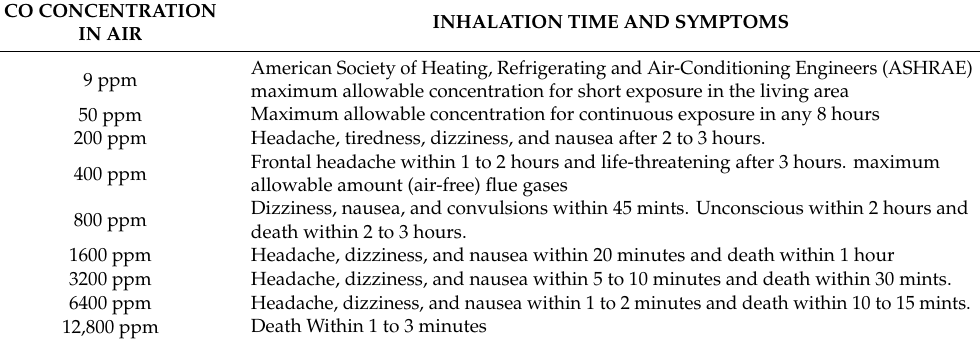
Table 2. E ff ects of CO on human health